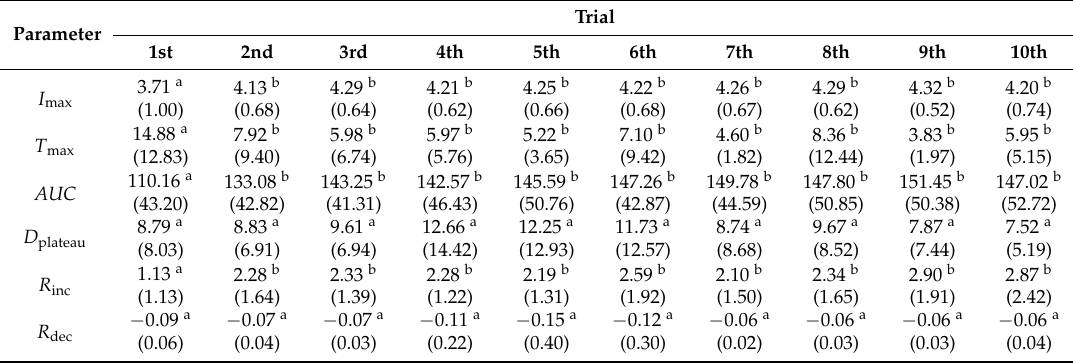
Table 1. Multiple comparisons of paired trials for significant simple main effects of trial number for each TI